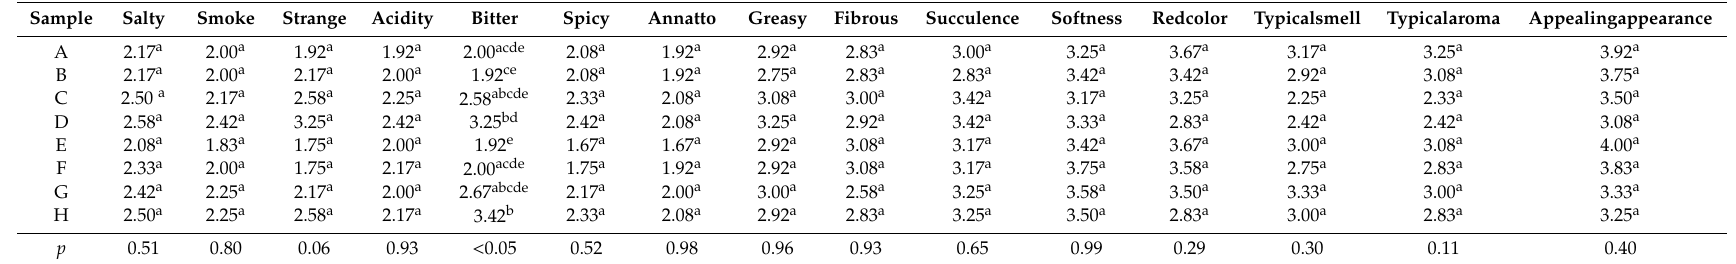
Table 3. Results of the first tasting for the descriptors for the analyzed